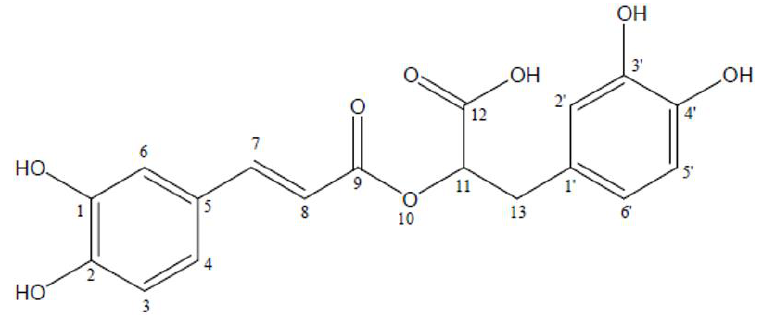
Figure 1. Chemical structure of the rosmarinic acid.